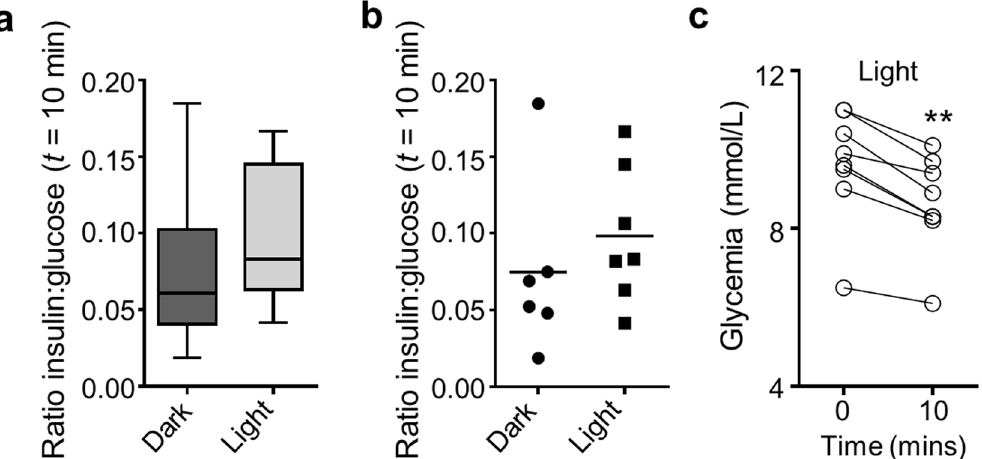
Figure 5. JB253 and insulin secretion. ( a ) Box and whiskers plot showing that insulin secretion, normalized as the ratio insulin:glucose, tends to increase during illumination in JB253-treated animals (median and range shown). ( b ) As for ( a ), but scatter plot to show the presence of a single outlier (mean is shown). ( c ) Before- and-after plot showing that glucose concentrations decreased during illumination in all JB253-treated animals examined. ** P < 0.01, paired Student’s t